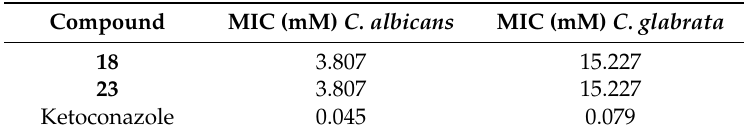
Table 2. Antimycotic effect for selected